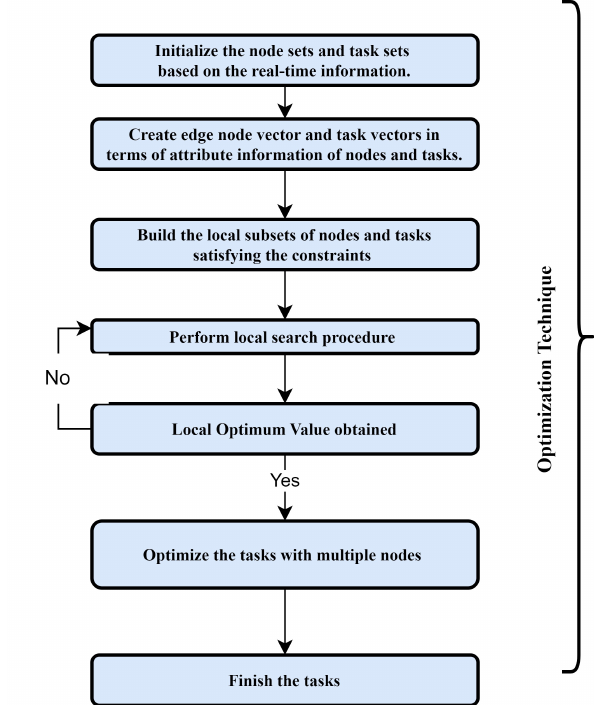
Figure 6. Flowchart of the proposed